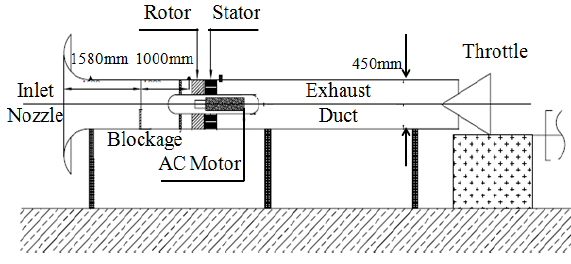
Figure 1. Compressor test rig.